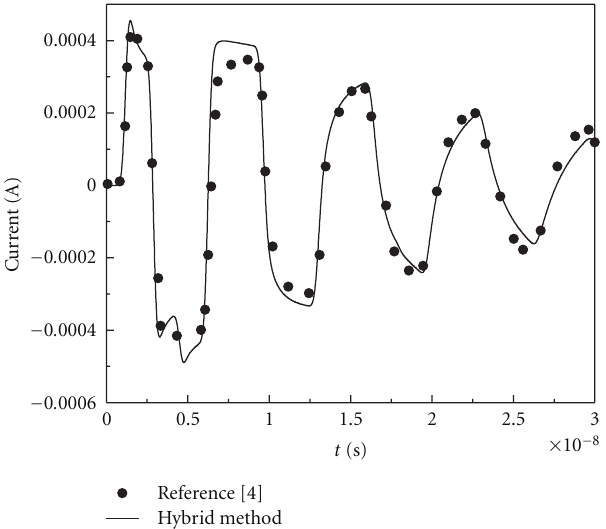
1 subfield. (cid:0)